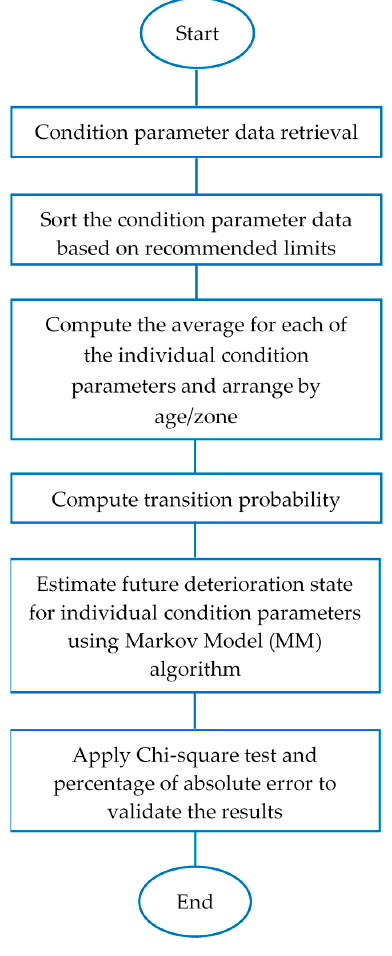
Figure 1. Framework for modelling the future condition parameters of the transformer population according to Markov Model (MM).